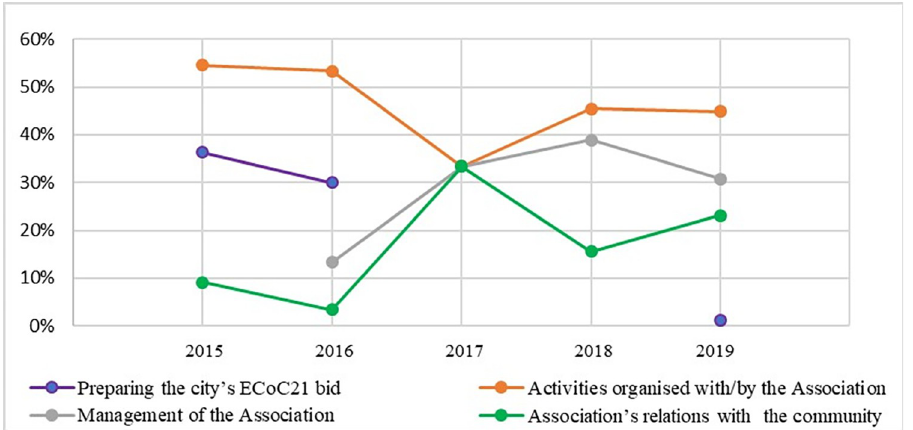
Fig 3. Thematic trends in the publication of press articles,